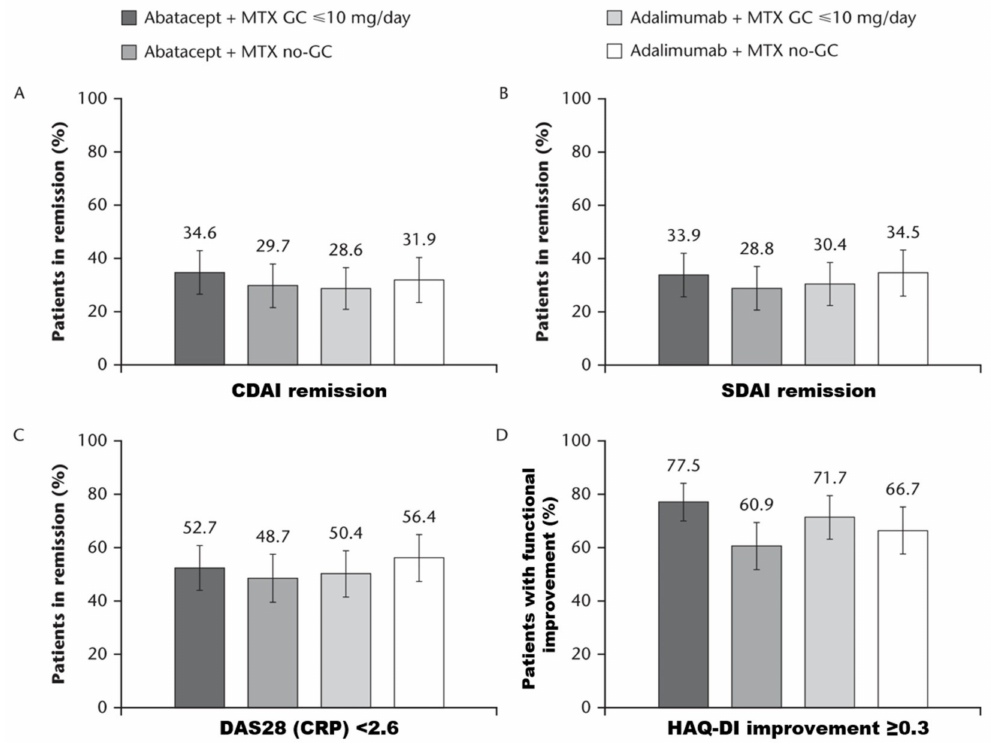
Figure 1. Clinical outcomes at Year 2. Proportion of patients (95% CI) achieving ( A ) CDAI remission, ( B ) SDAI remission, ( C ) DAS28 (CRP) < 2.6, or ( D ) HAQ-DI improvement ≥ 0.3 at Year 2 in abatacept + MTX or adalimumab + MTX GC ( ≤ 10 mg / day) and no-GC subgroups. CDAI